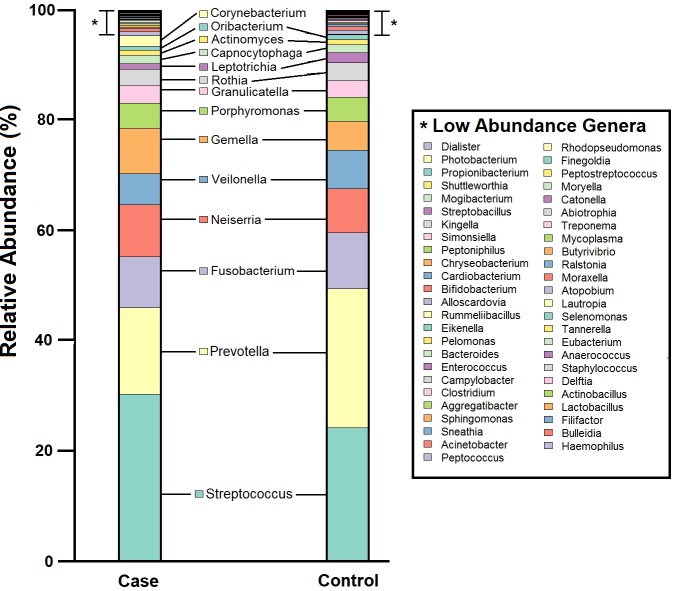
Pharyngeal microbiome profile of the study population, at genus level.Cumulative relative abundance of each of the 63 bacterial genera in case and control samples. Microbial community members with relative abundance <0.1% are listed as Low Abundance Genera (indicated by “*”).